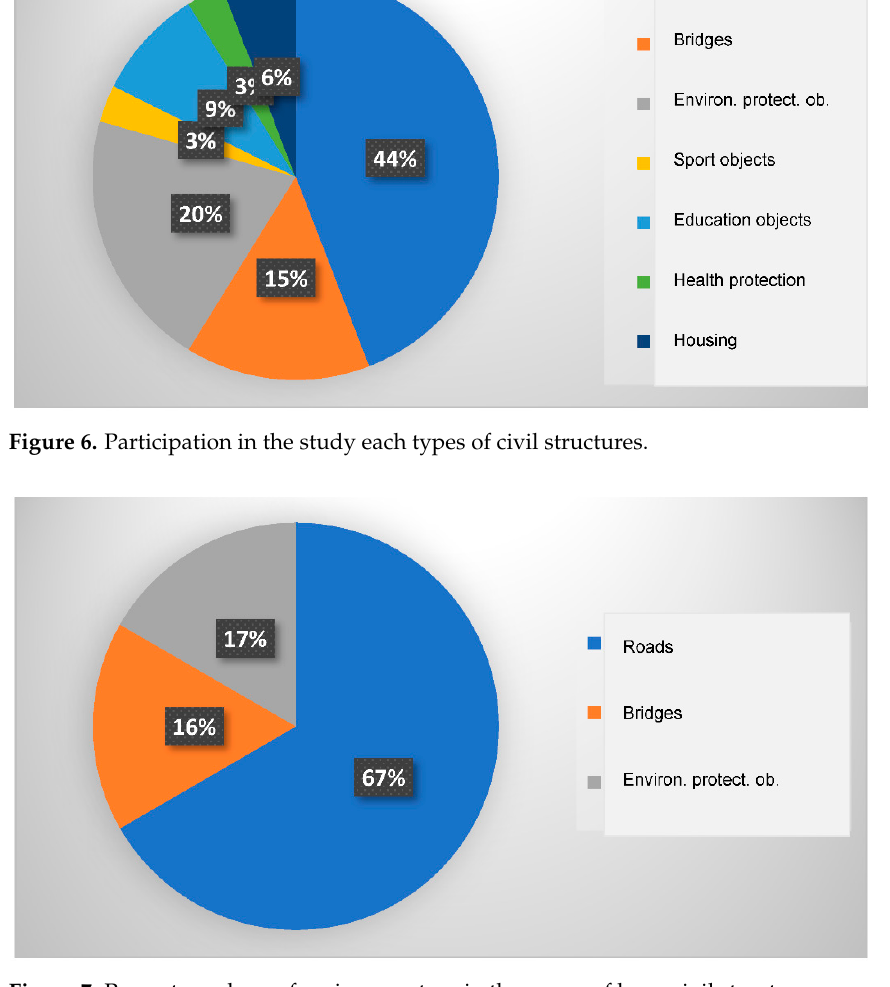
Figure 7. Percentage share of various venture in the group of large civil structures.